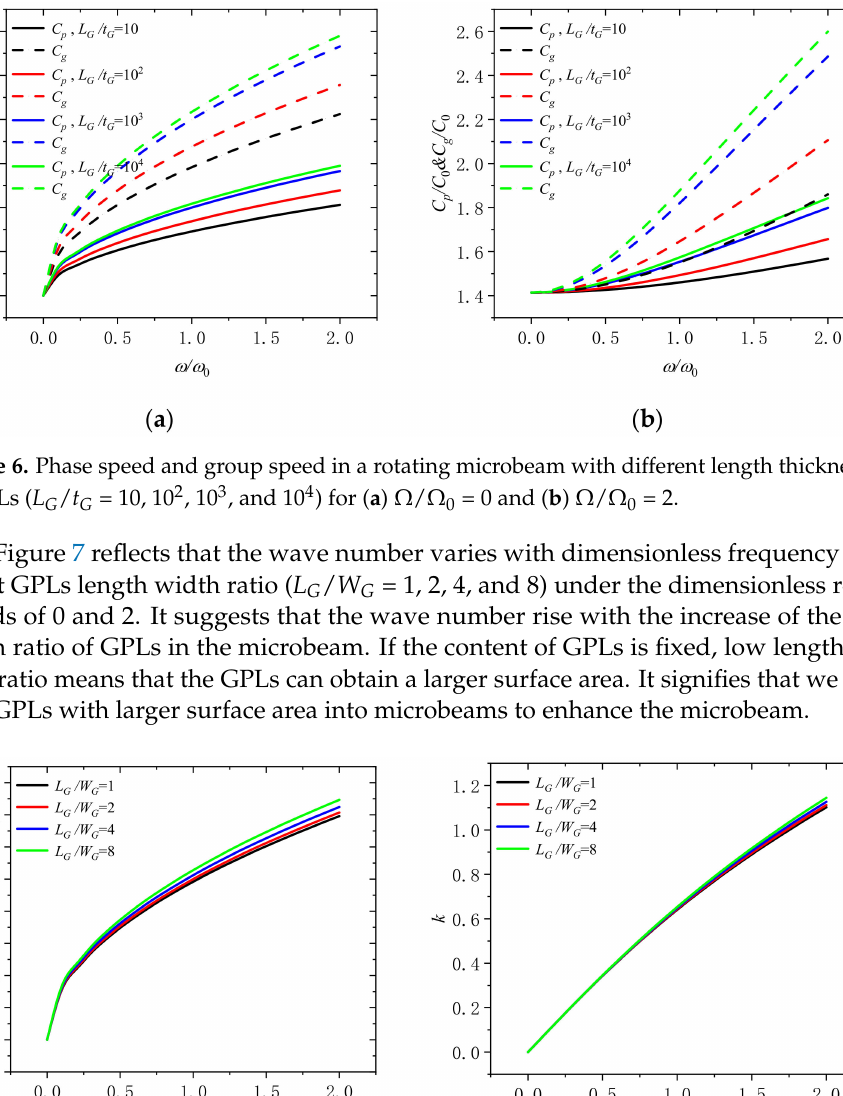
larger surface area into microbeams, which is beneficial to enhance the